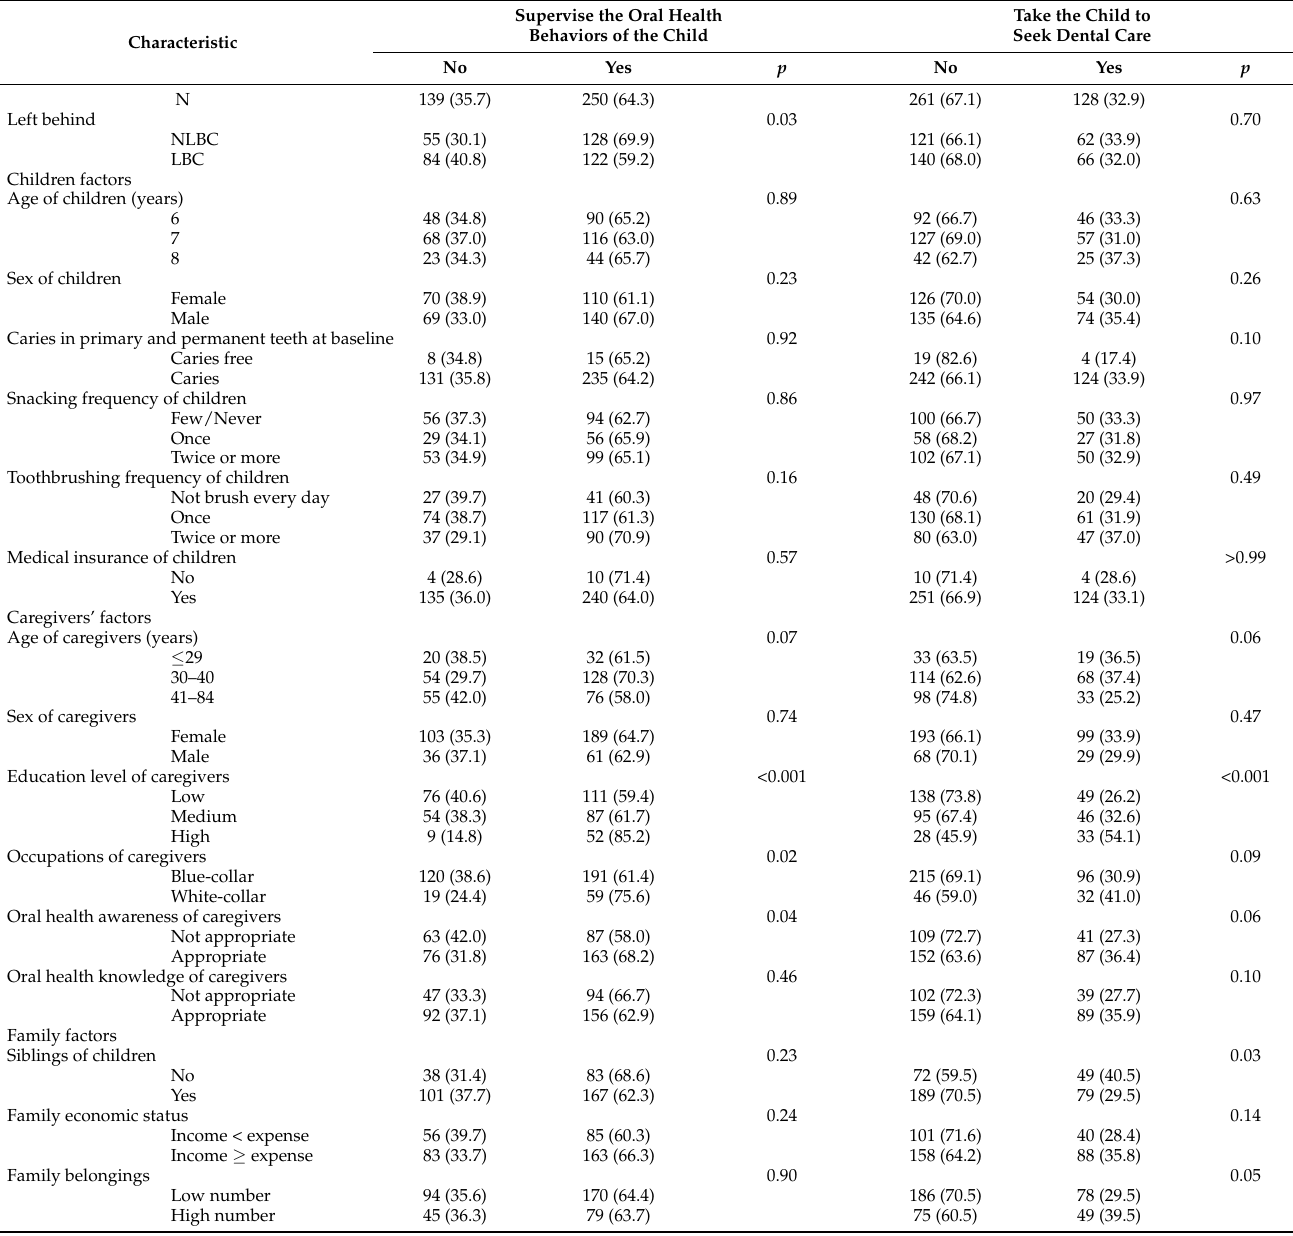
Table 1. Comparison of compliance with advice on characteristics of participants, n